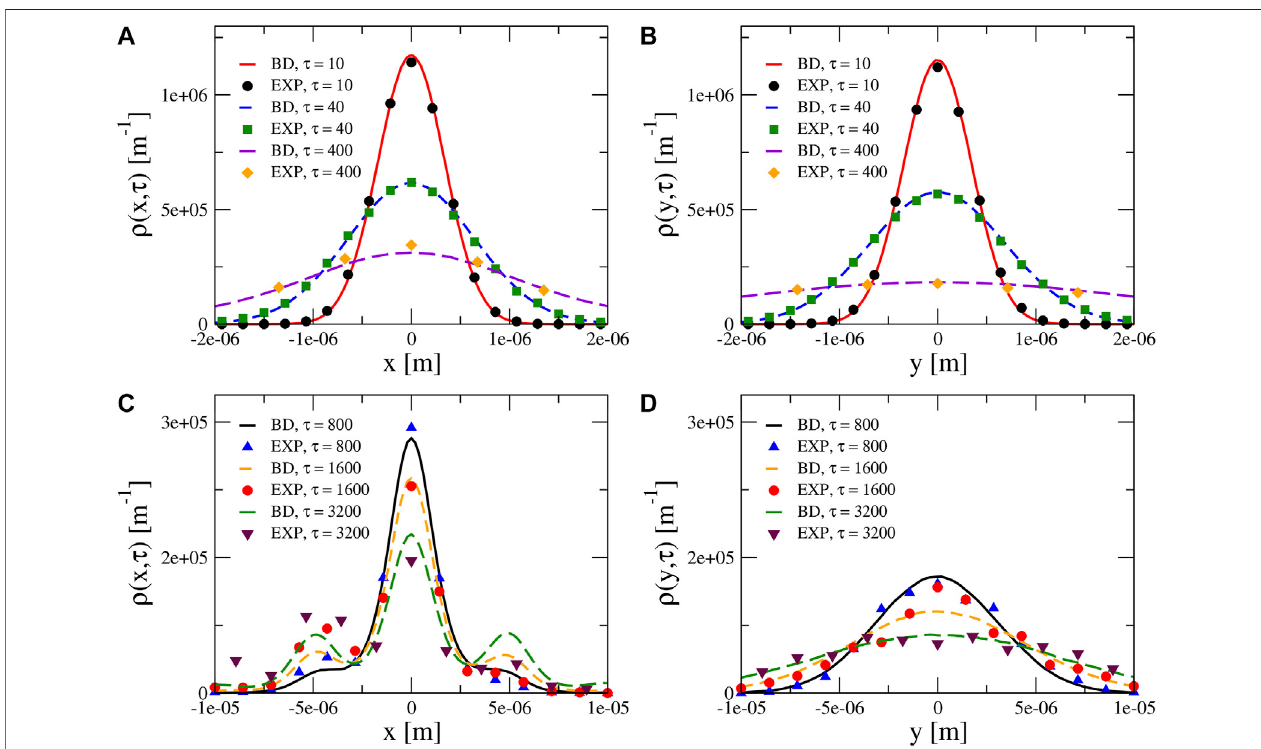
FIGURE4| (Coloronline):Densityofprobabilityperunitlengthof fi ndingatracer ρ ( x , τ ) asafunctionofthepositionandthereducedtime τ (cid:2) t / Δ t ,with Δ t (cid:2) ( 1 / 30 ) s .In panels (A,C) there is an applied periodic cosine-like external fi eld in the x -axis direction. In panels (B,D) there is not an applied external fi eld in the y -axis direction. Symbols correspond to experimental measurements. Lines are associated to Brownian dynamics simulations in which D 0 (cid:2) 1 . 8 × 10 − 13 m 2 / s and U 0 (cid:2) 1 . 33 k B T .